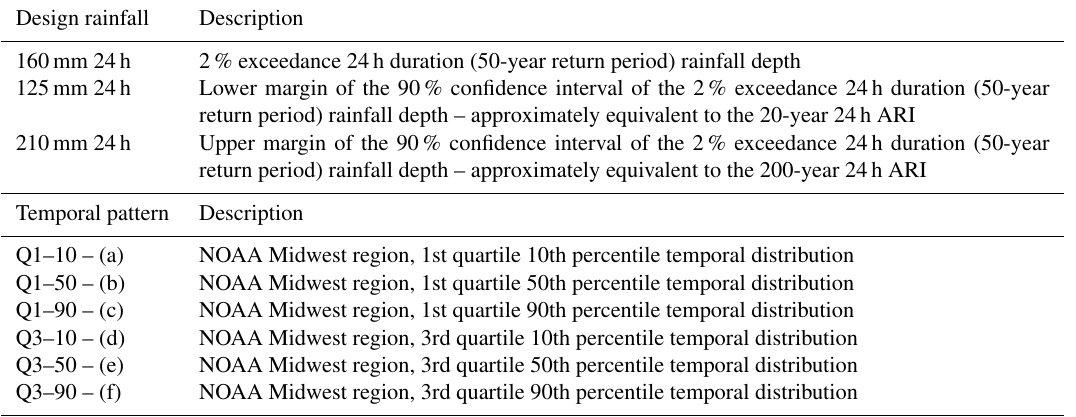
Table 2. Description of notation used in reference to the modeled storm depths and temporal distributions (NOAA Atlas 14 Volume 8 Appendix 5 accessed from http://www.nws.noaa.gov/oh/hdsc/PF_documents/Atlas14_Volume8.pdf) (see Fig. 2). ARI represents the average recurrence